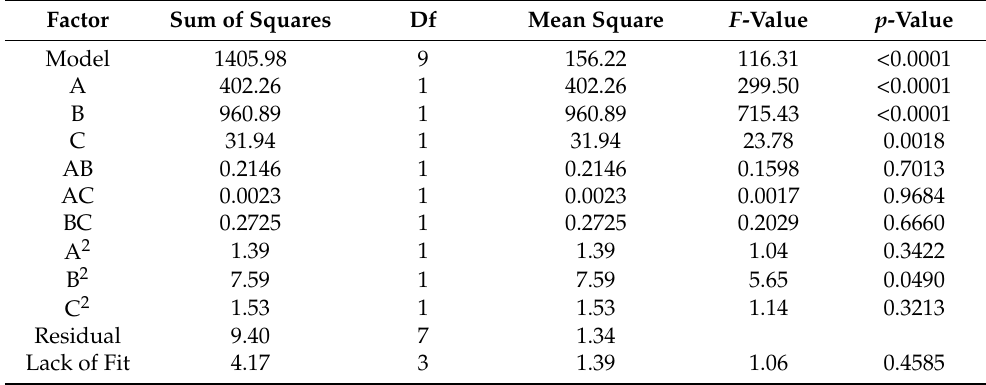
Table 4. The results of the analysis of variance